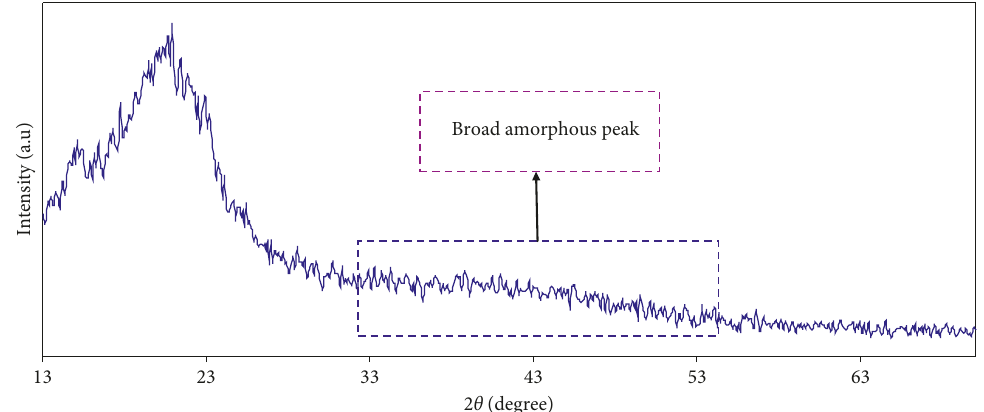
Figure 1: XRD pattern for the pure chitosan (CS)